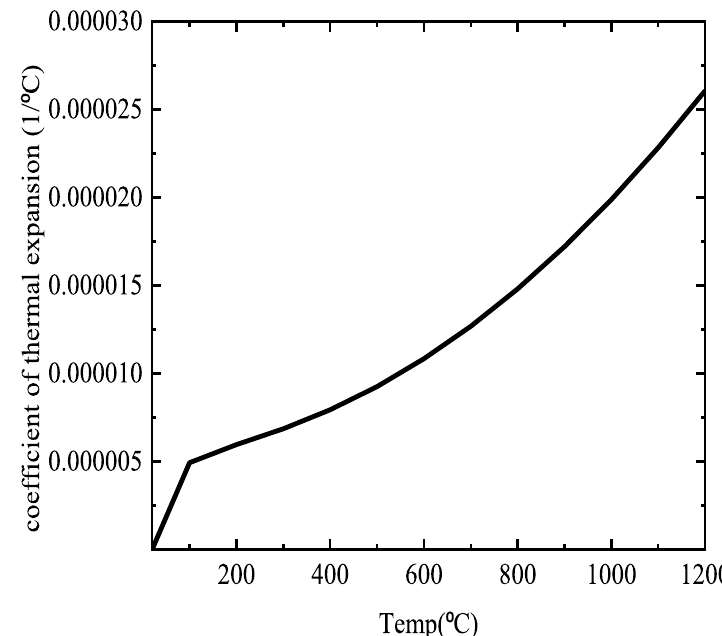
Fig. 14 Coefficient of thermal expansion of concrete at elevated temperatures